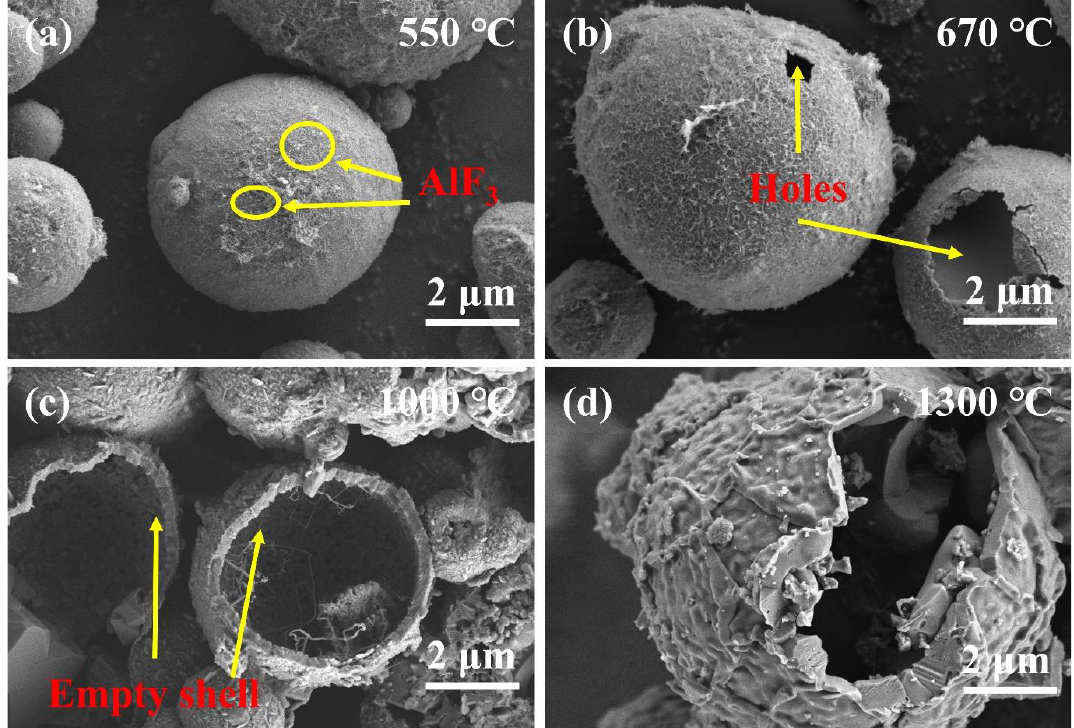
Figure 6. SEM images of oxidation products of Al@PVDF powders at different temperatures. ( a ) 550 °C; ( b ) 670 °C; ( c ) 1000 °C; ( d ) 1300 °C. The products were recovered from TG-DSC